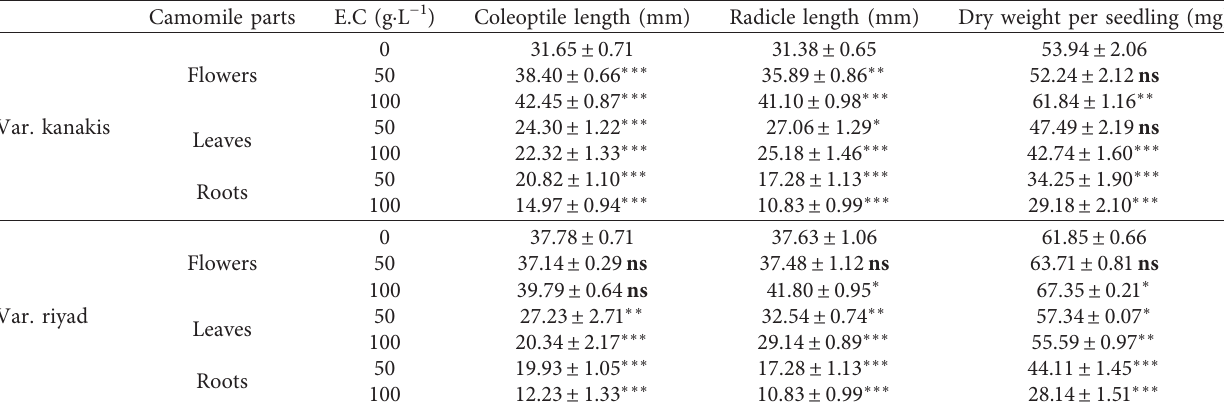
Table 2: Effects of chamomile aqueous extracts on seedling growth of the durum wheat kanakis and riyad variety. Camomile